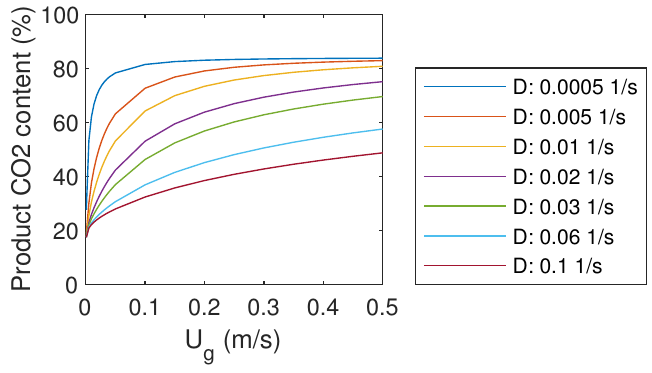
Figure 4. Product gas CO 2 content.